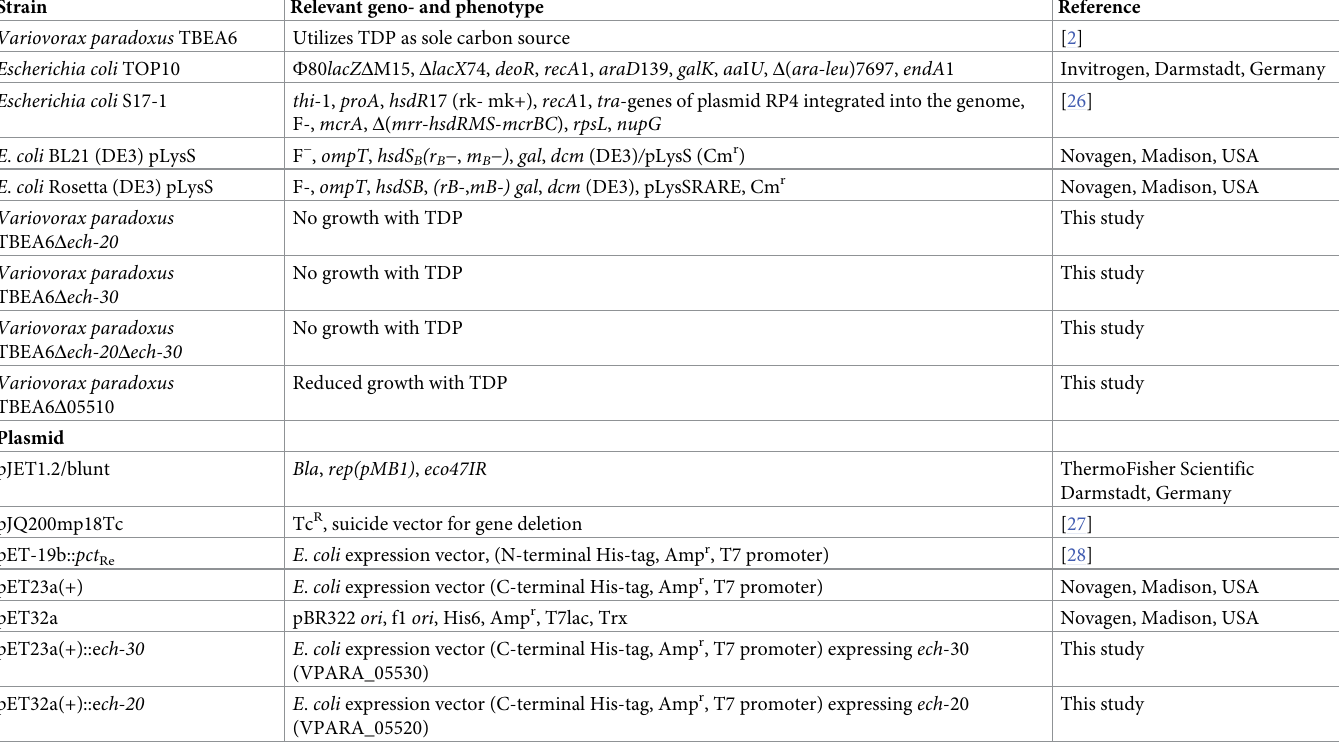
Table 1. Strains and plasmids used in this